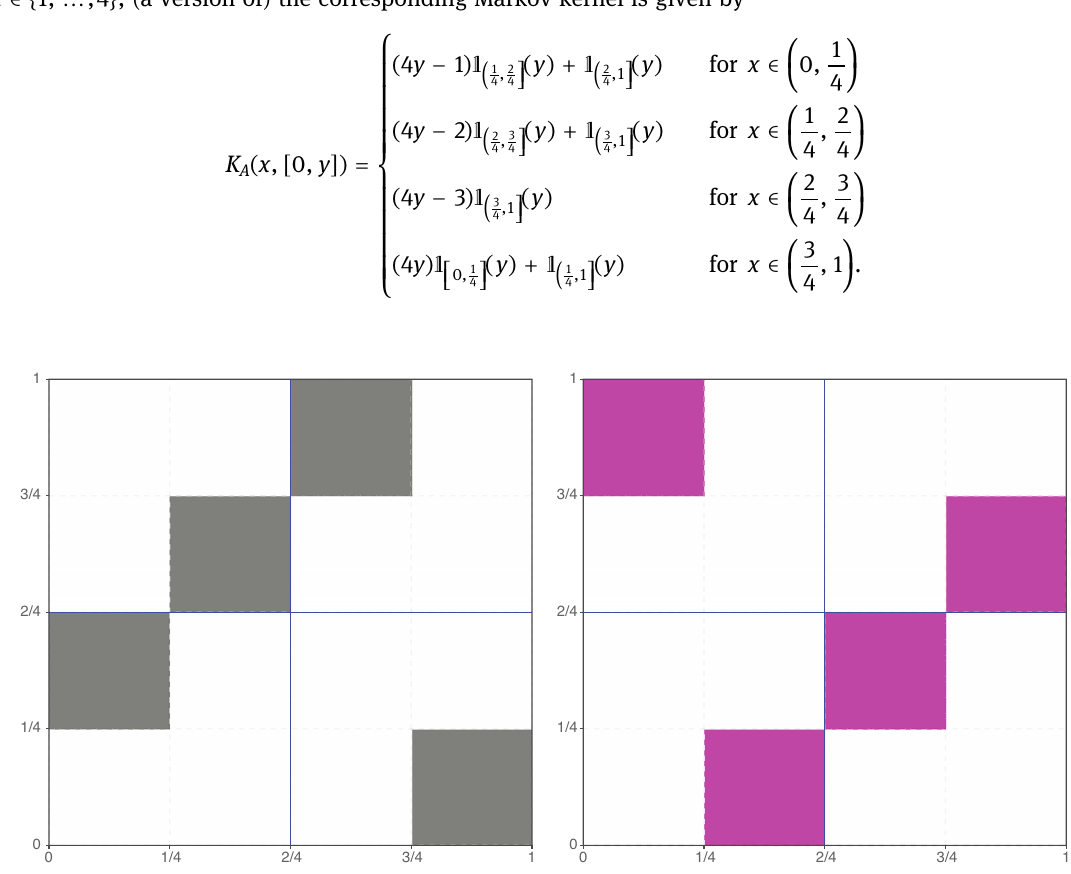
Figure 4: Density of the copula A ( left panel ) and the copula A t ( right panel ) considered in Example 5.4. The copula A has maximal D 1 - asymmetry, i.e., κ